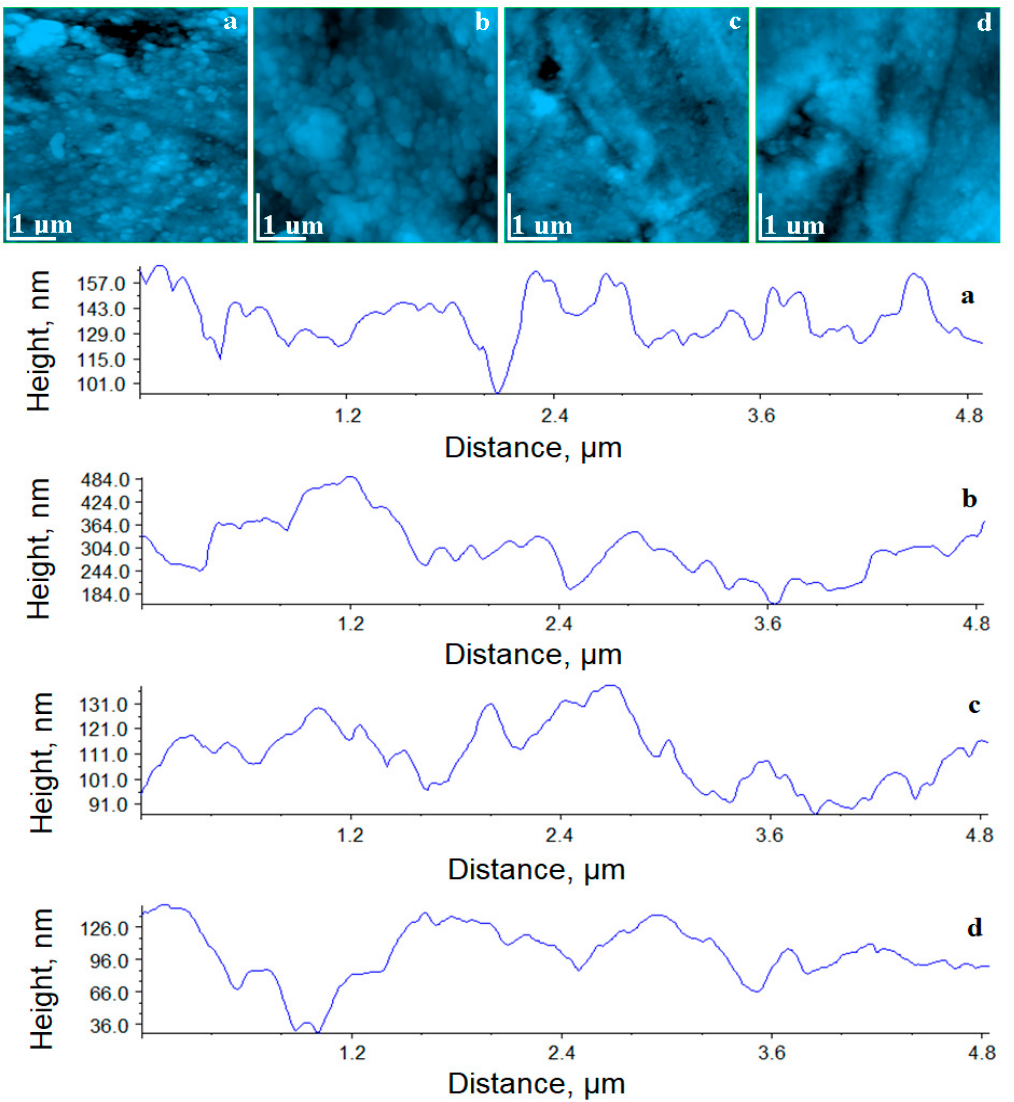
Figure 4. AFM topographic images for the reference samples: ( a ) Adoro, ( b ) Variolink, ( c ) Relyx, and ( d ) Solidex. Profiles on the horizontal median of each image are provided.